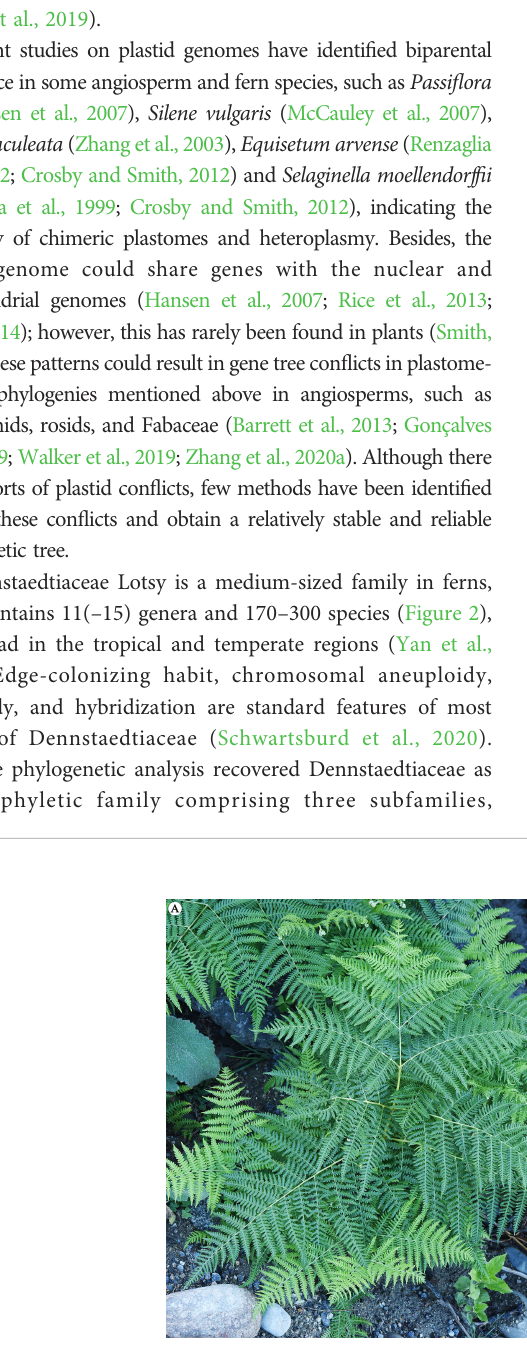
FIGURE 2 Morphological characteristics of Dennstaedtiaceae. (A – G) Hypolepidoid clade; (A, B) Pteridium aquilinum ; (C) Blotiella sp.; (D) Hiya brooksiae ; (E) Hypolepis tenuifolia ; (F) Histiopteris incisa ; (G) Paesia radula ; (H, I) Dennstaedtioid clade; (H) Microlepia hancei ; (I) Dennstaedtia scabra var. glabrescens ; (J-K) . Monachosoroideae; (J) Monachosorum henryi ; (K) Monachosorum maximowiczii